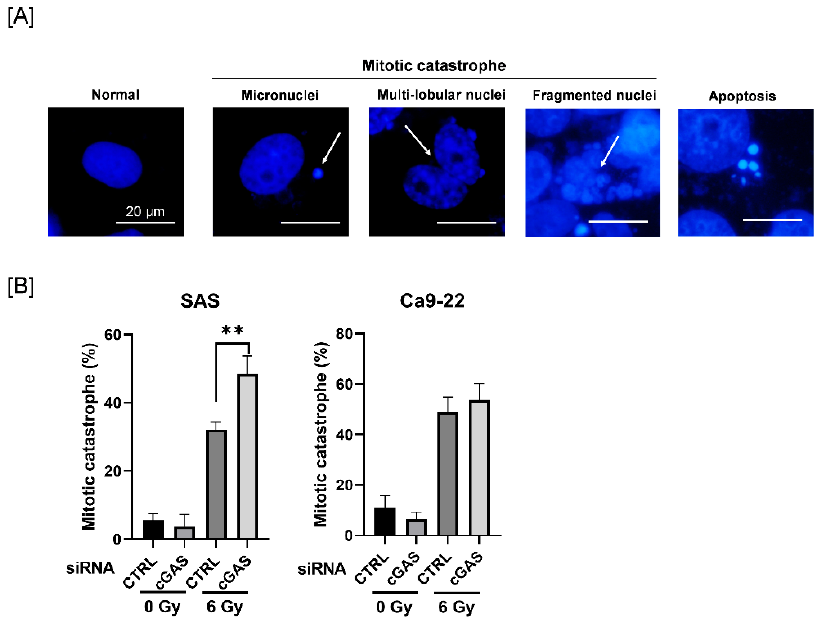
Figure 3. Effect of cGAS knockdown on radiation-induced mitotic catastrophe in HNSCC cells. ( A , B ) HNSCC cells transfected with the control or cGAS siRNA were harvested and treated with 6 Gy. After four days of culture, the cells were harvested for the analysis of mitotic catastrophe. ( A ) Representative pictures of mitotic catastrophe are shown. Micronuclei, multilobed nuclei, and fragmented nuclei were counted as indicating mitotic catastrophe. The arrows indicate the cells undergoing mitotic catastrophe. ( B ) The percentages of mitotic catastrophe cells are shown. ** indicate p < 0.01, respectively.